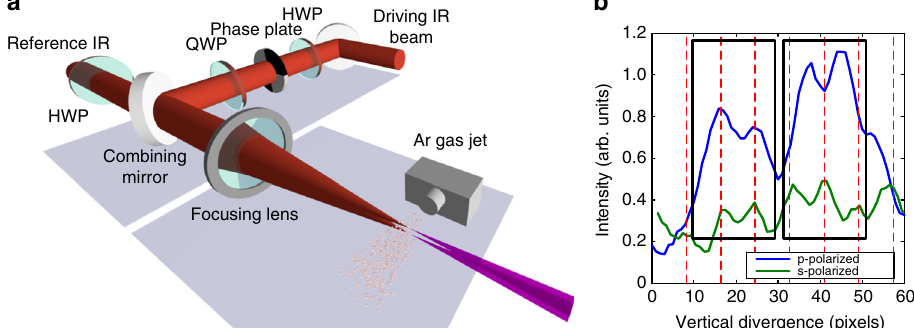
Fig. 4 Measuring interference between an XUV vector beam and a XUV reference beam. a Experimental setup. The polarization of the reference beam is controlled by a half-wave plate (HWP) for the fundamental. The XUV beams are spectrally resolved and spatially overlapped in an XUV spectrometer. The interference images are recorded by the micro-channel plate (MCP). b Interference between the XUV reference and vector beam. The blue curve shows the fringes when the reference beam is p-polarized, and the green curve shows the fringes when the reference beam is s-polarized. The dotted red lines indicate periods of the modulation. All the red dotted lines aligned with all the peaks of the green curve, which indicates the s-component at intersections are all in phase. For the p-component shown with the blue curve, either the peaks or the valleys are aligned with the red dotted line, and that indicates p-components at intersections that are out of phase with respect to the adjacent